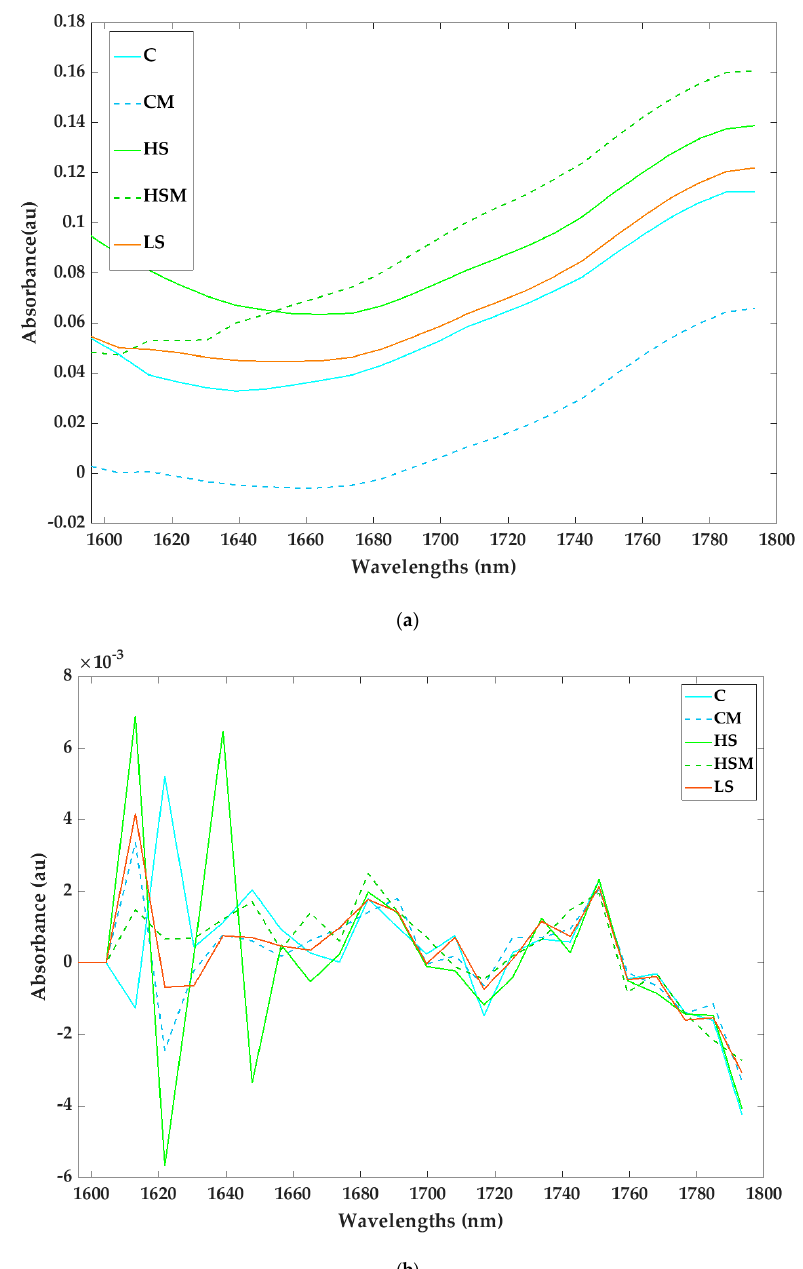
Figure 3. Raw leaf absorbance ( a ) and second derivative spectra ( b ) measured with the microPHAZIR TM near-infrared (NIR) analyzer for the di ff erent smoke and misting treatments. Abbreviations: C = control without misting; CM = control with misting; HS = high density smoke without misting; HSM = high density smoke with misting; and LS = low density